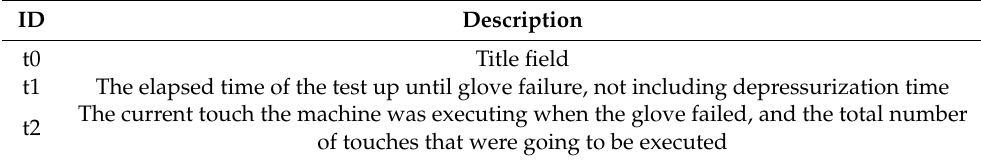
Table 8. Description of each text field found on the glove failure